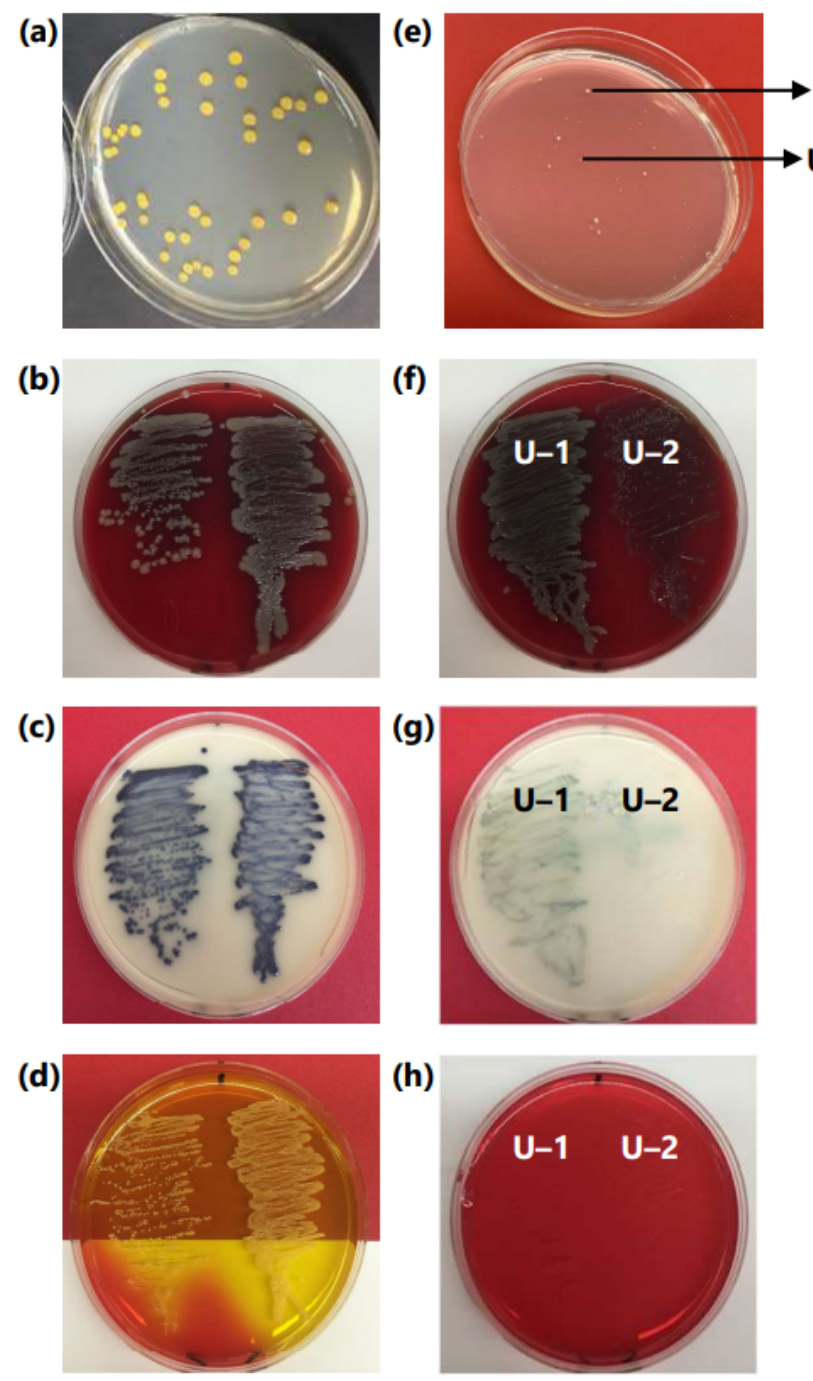
Figure 5. Assessment of MRSA and microsome using non-selective and selective solid nutrient media. ( a , e )—CAMH; ( b , f )—SBA; ( c , g )—Spectra MRSA; ( d , h )—MSA plates for ( a – d ): MRSA; ( e – h ): U–1 and U–2. U—contaminant microorganisms from microsome (unknowns).